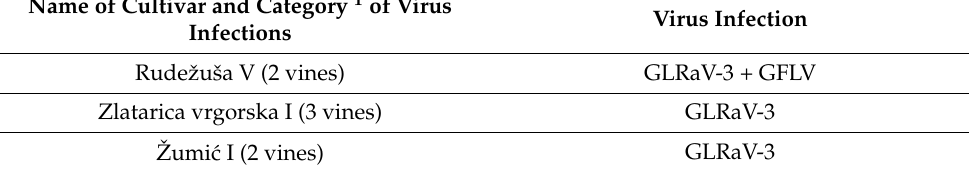
Table 1. Cont. Name of Cultivar and Category 1 of